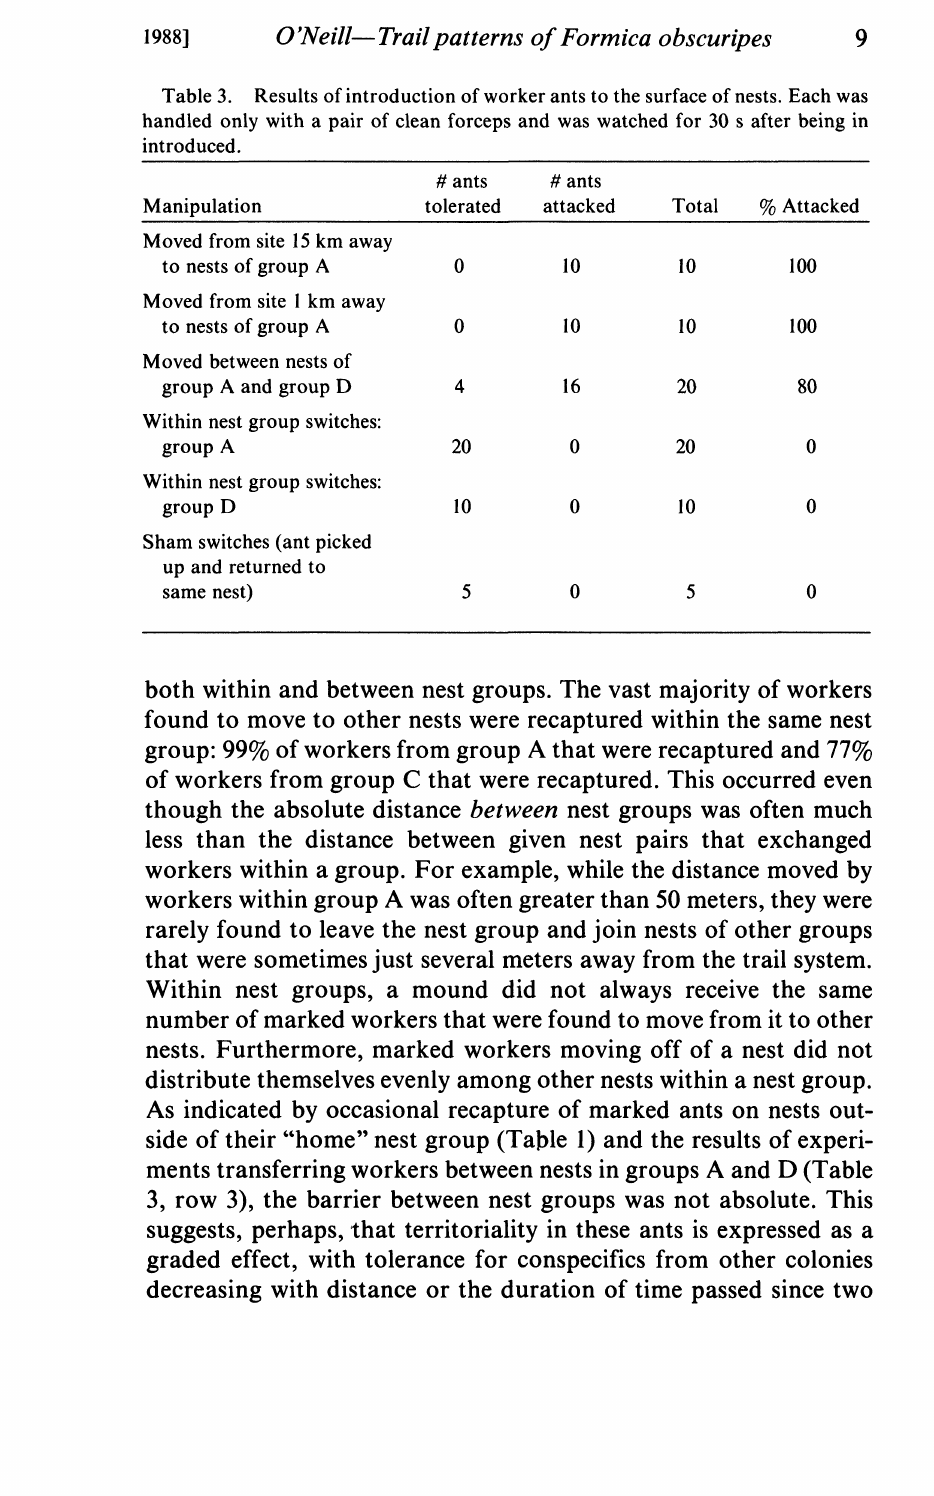
Table 3. Results of introduction of worker ants to the surface of nests. Each was handled only with a pair of clean forceps and was watched for 30 after being in